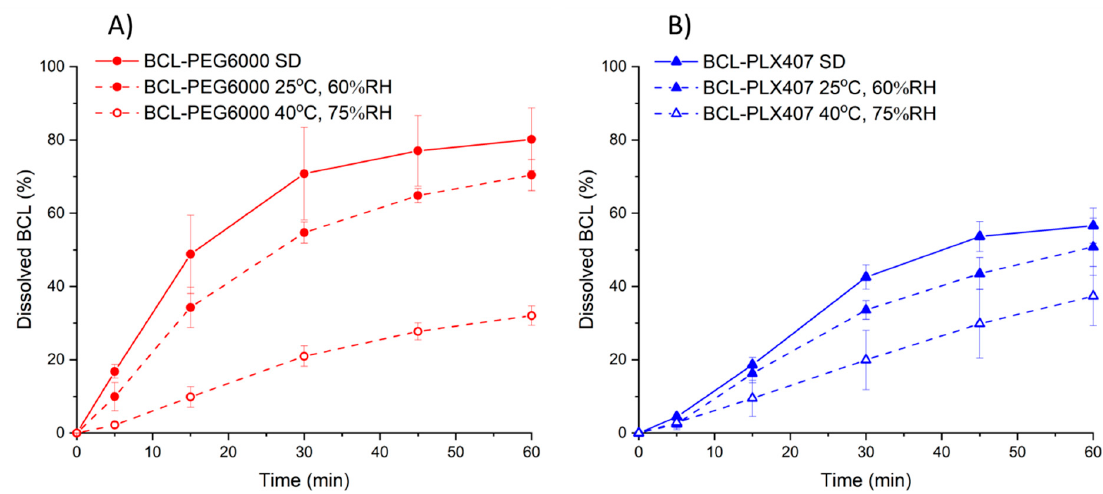
Figure 8. Release profiles of bicalutamide from tablets containing solid dispersion with either PEG6000 ( A ) or PLX4087 ( B ) after stability studies, in comparison with tablets analyzed after preparation.